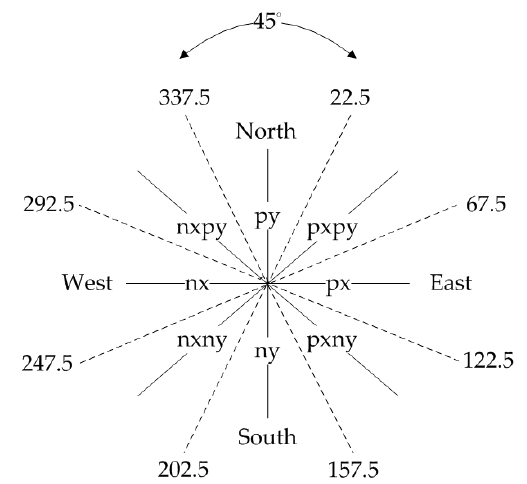
Figure 4. Schematic diagram of aspects of slope excavation at portal. The cutting slope safety factor ( FS ) in eight different directions. Each assessing area was set at every 45° interval and was divided as a slope aspect, clockwise. p symbolizes positive and n symbolizes negative. x is x-axis and y is y-axis.